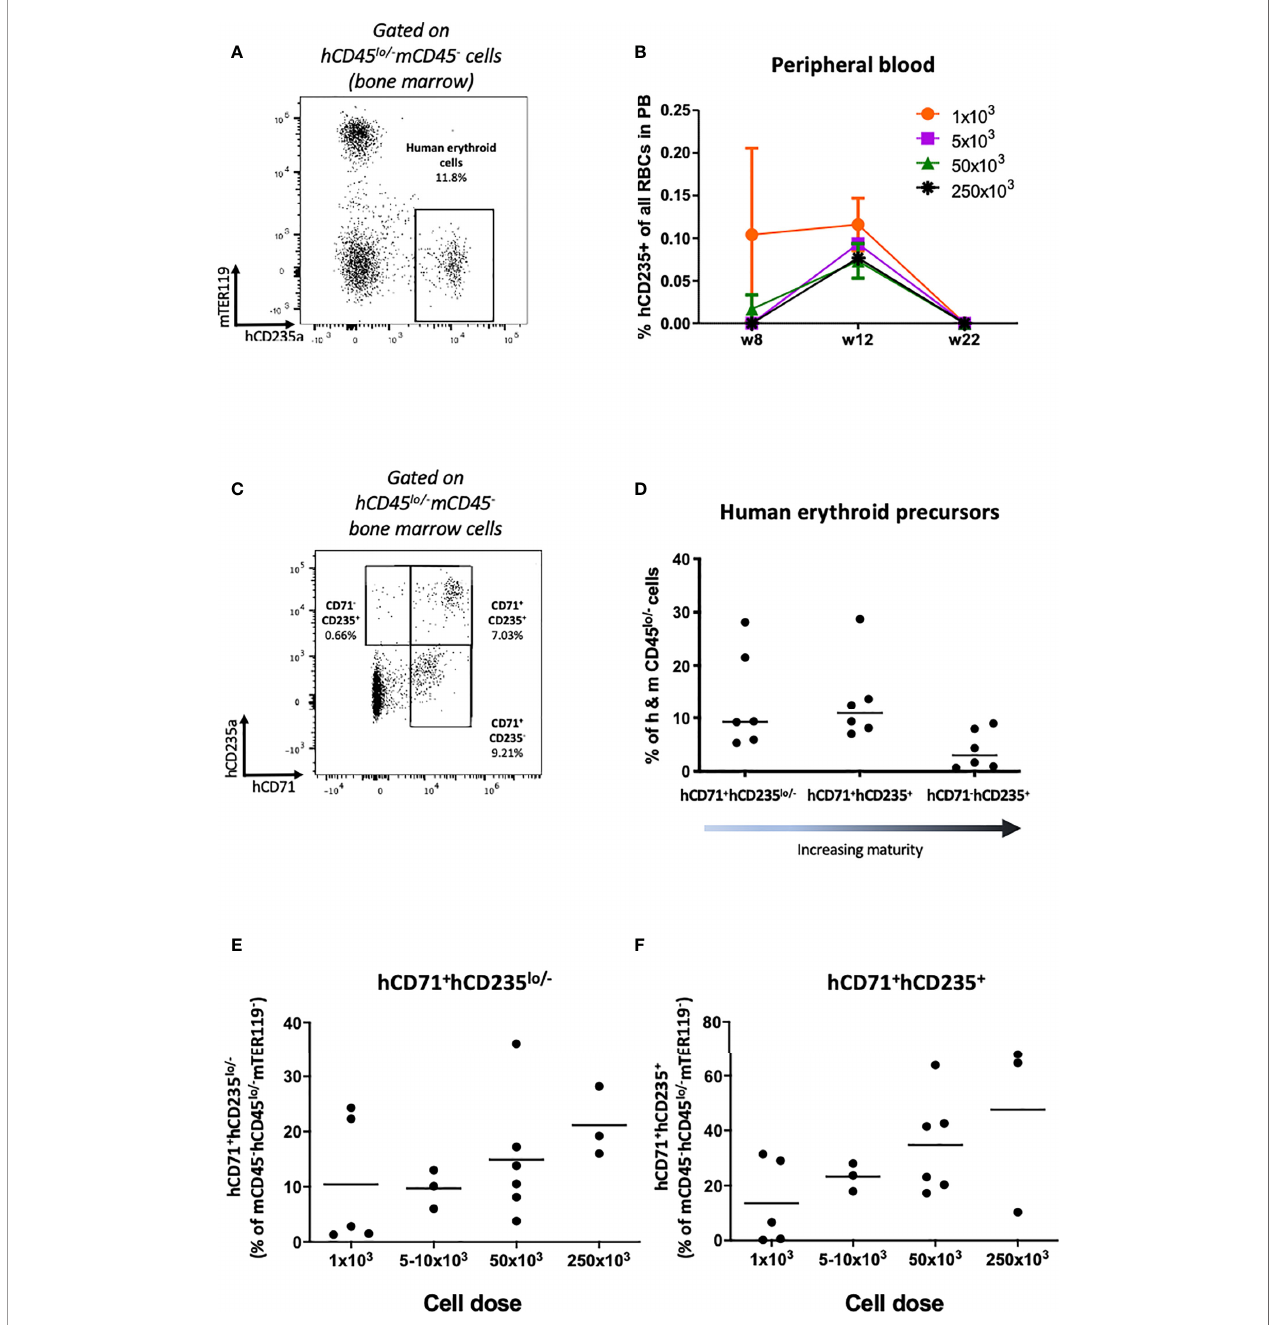
FIGURE 7 | Human erythrocyte reconstitution in HSPC-NBSGW mice. (A) Representative fl ow cytometric analysis demonstrating the identi fi cation of hCD45 lo/- mCD45 - hCD235a + mTER119 - human erythroid cells in the bone marrow. (B) Frequency of hCD235 + cells in the peripheral blood at different time points following injection with increasing numbers of hUCB CD133 + HSPCs (mean ± SD shown). (C) Representative fl ow cytometric analysis and (D) corresponding frequencies of hCD71 + hCD235 lo/- , hCD71 + hCD235 + and hCD71 - hCD235 + erythroid precursors (in ascending order of maturity) in the bone marrow (BM) 20-22 weeks after humanization (50x10 3 dose shown). (E) Frequency of hCD71 + hCD235 -/lo and (F) hCD71 + hCD235 + erythroid precursors in the bone marrow (BM) following humanization with increasing numbers of hUCB CD133 + HSPCs. Red symbols – female mice, blue symbols – male mice. Bars indicate median